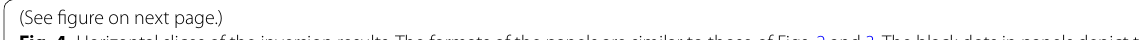
(See figure on next page.) Fig. 4 Horizontal slices of the inversion results. The formats of the panels are similar to those of Figs. 2 and 3. The black dots in panels depict